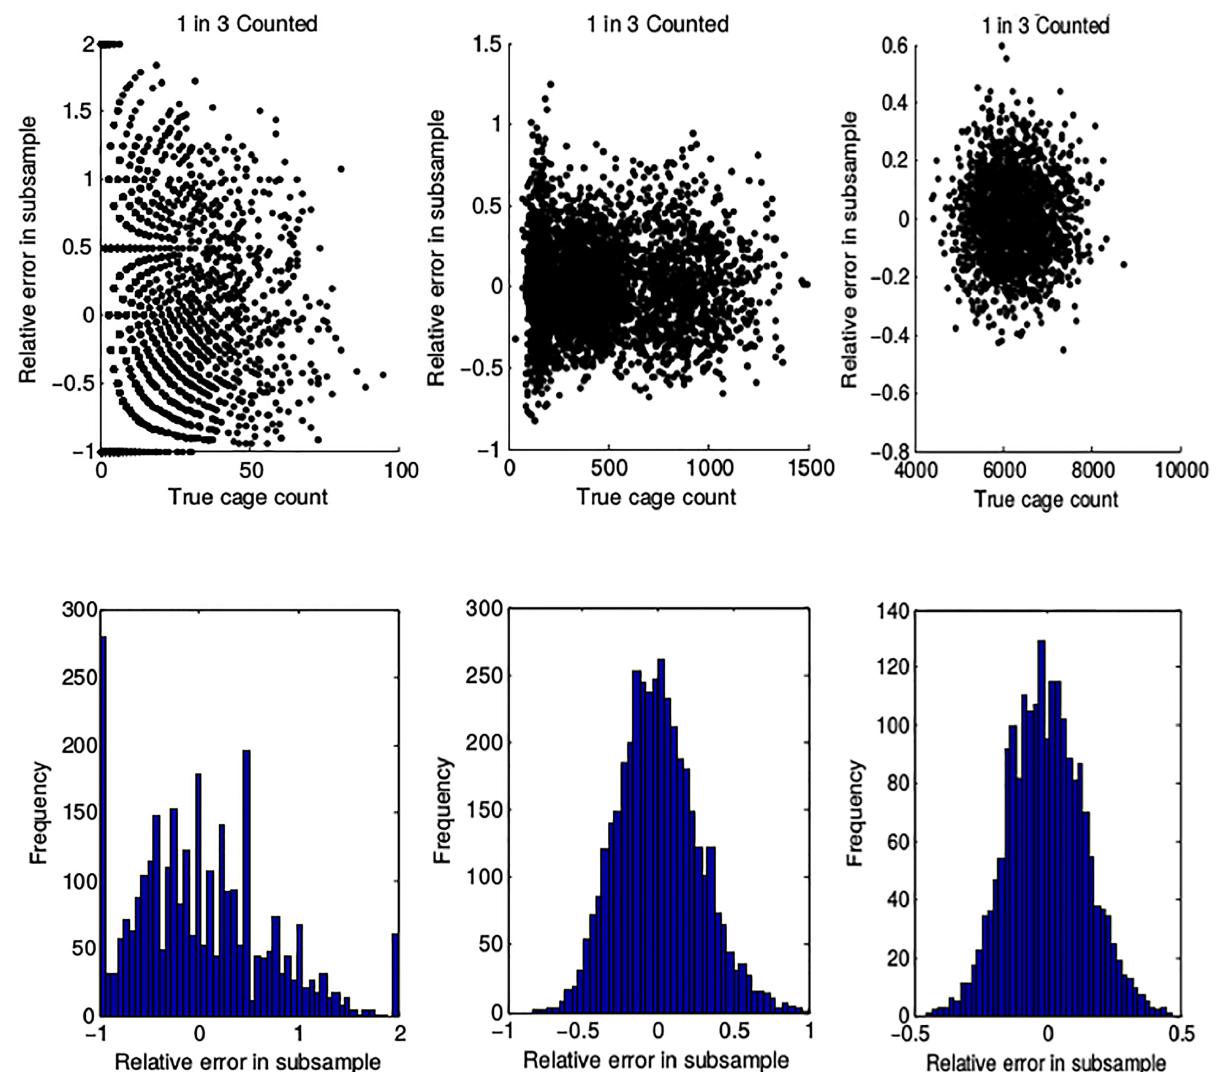
Fig 5. Normalized errors induced by subsampling at a 1-in-3 rate for synthetic data. Left: data in the ranges of [0, 100]. Middle: data in the ranges of [150, 1500]. Right: data in the ranges of [4000,